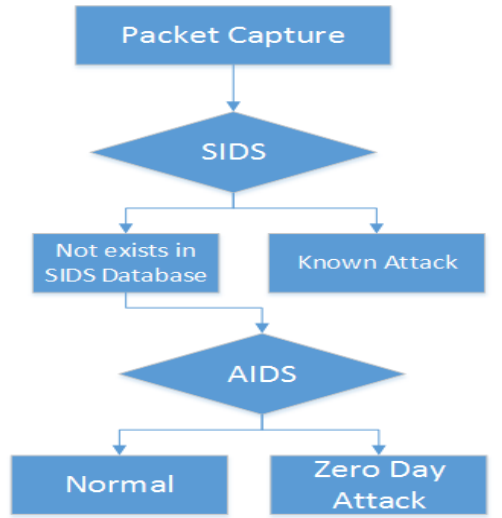
Figure 2. Hybrid intrusion detection system flowchart .